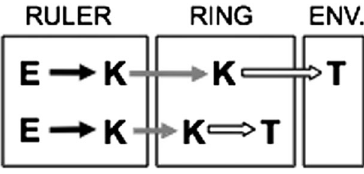
FIG. 4. Energy tracking diagram for ring slider scenario. E , K , and T represent elastic, kinetic, and thermal energy. Black, gray, and white arrows represent elastic expansion, mechanical work, and